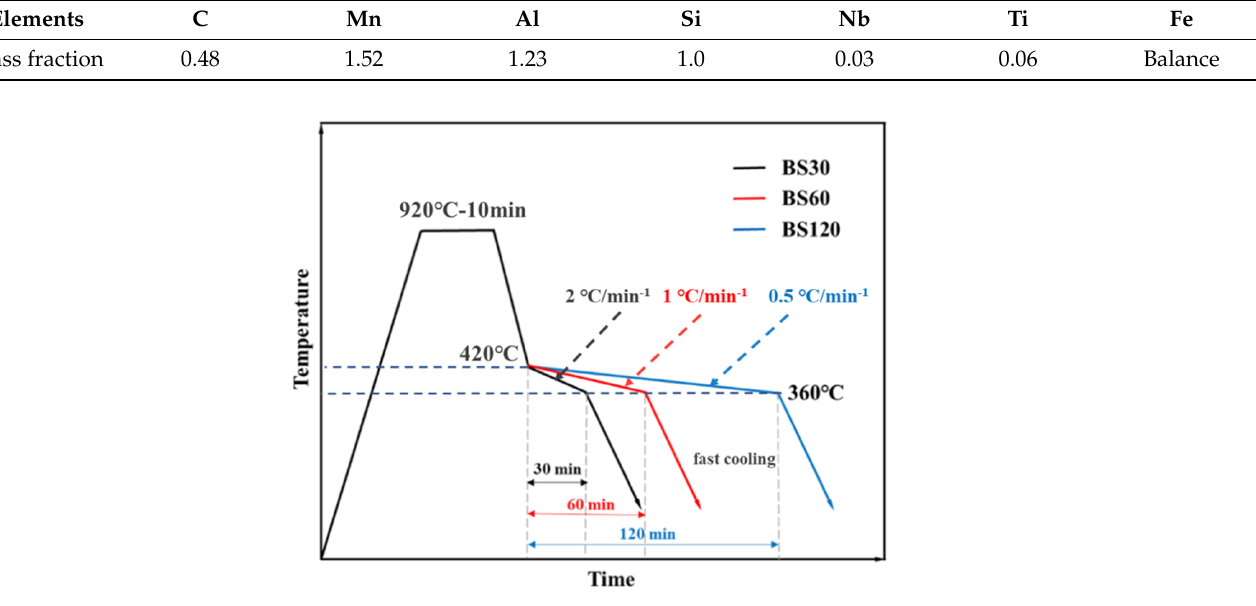
Figure 1. The applied heat treatment processes applied in this study.